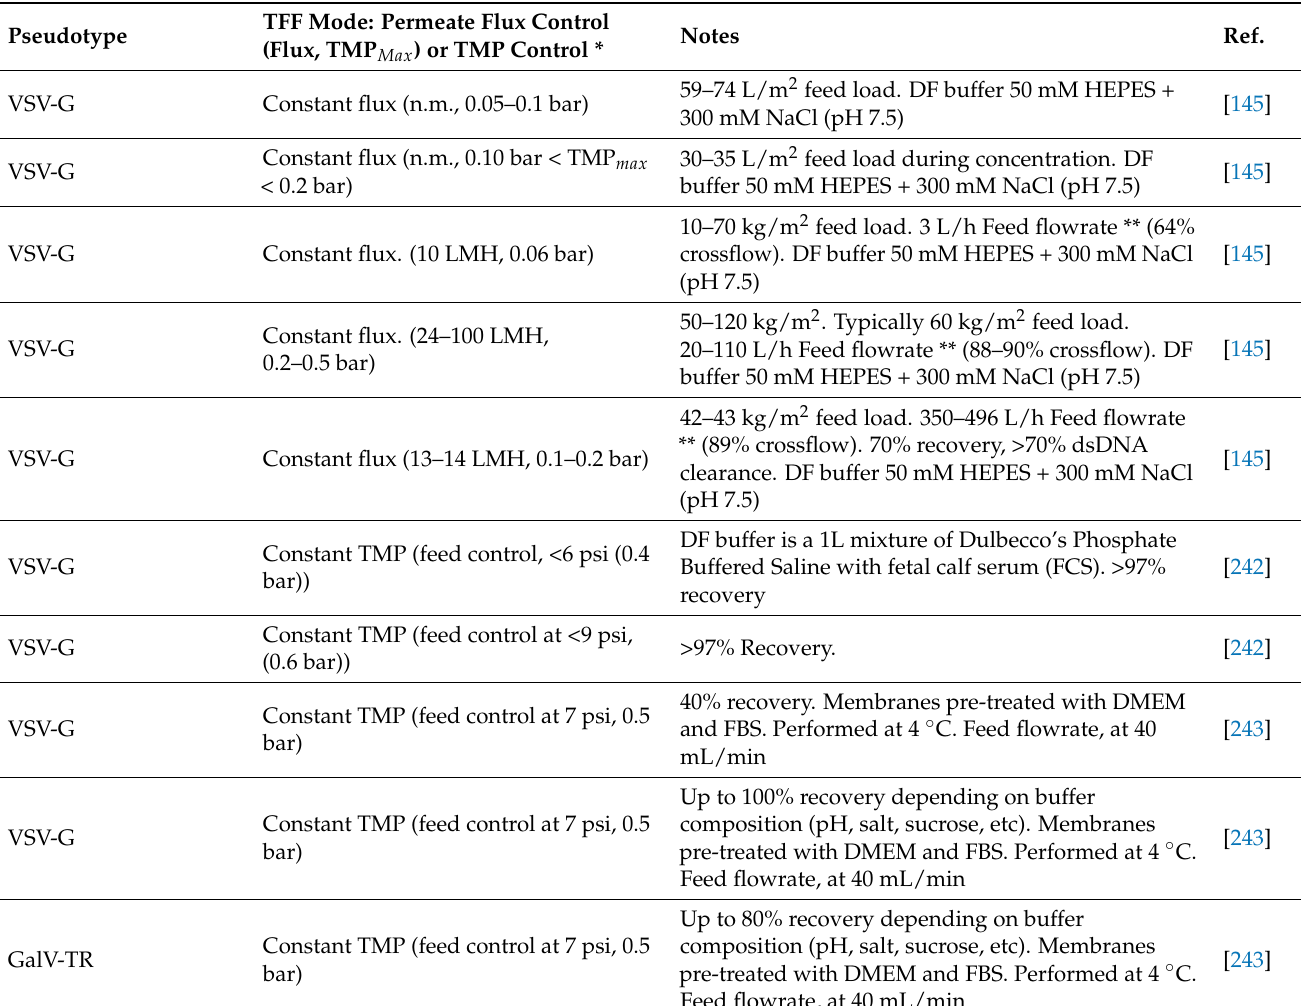
Table 8. Examples of tangential flow filtration operating conditions in lentiviral vector